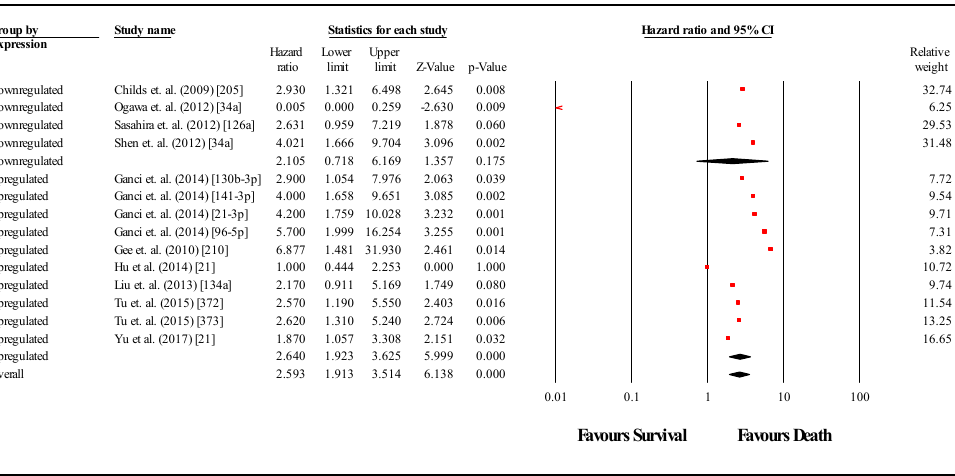
Figure 2. Forest plots for the miRNAs associated with OS. ( A ) Upregulated miRNA; ( B ) Downregulated miRNA.